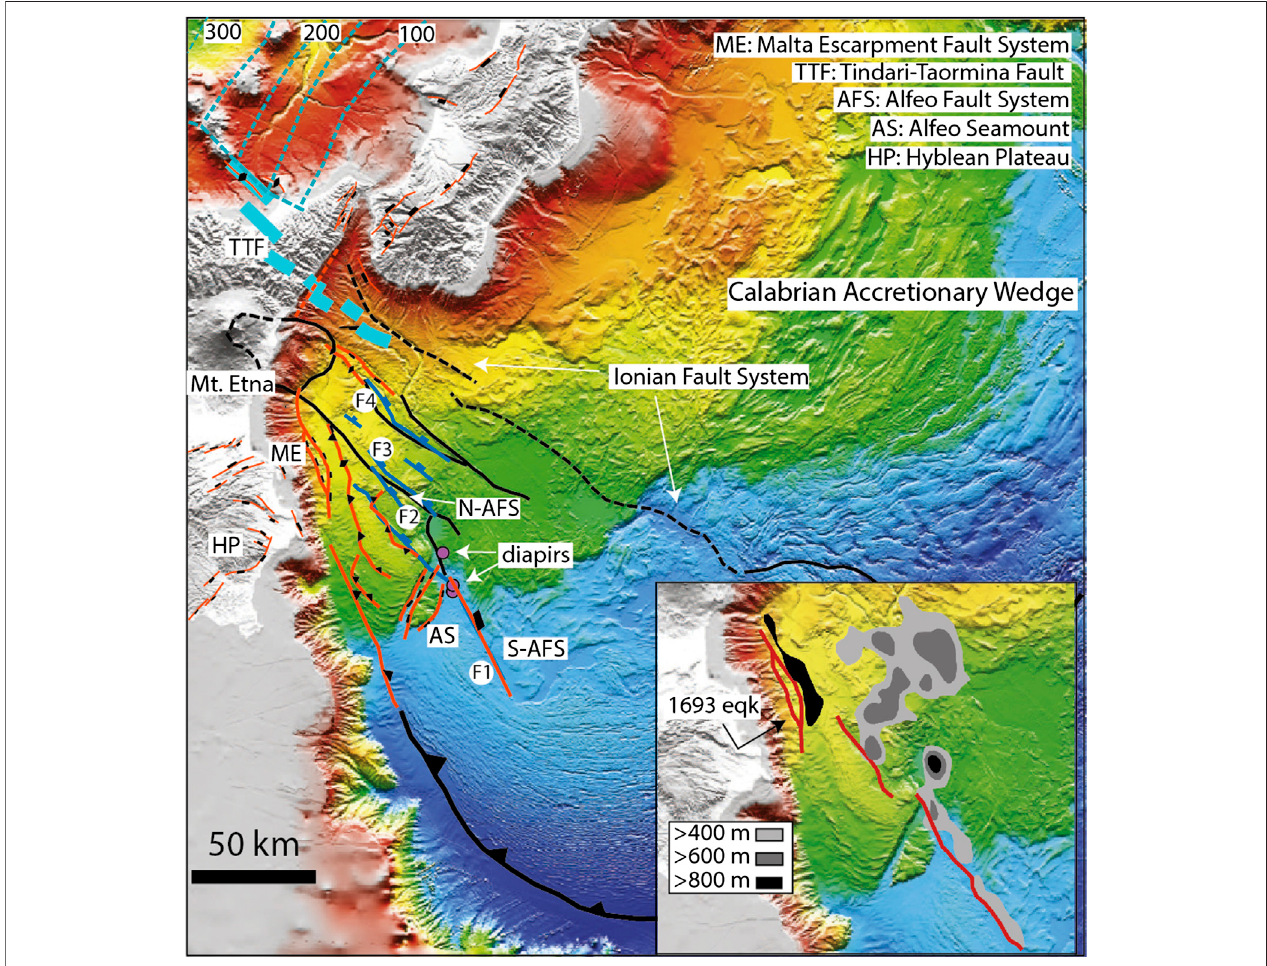
FIGURE 1 | Simpli fi ed tectonic map of the western Ionian region, showing a compilation of the main structural features. Faults are from Argnani, 2014 (in red), and from Gutscher et al., 2017 (in black); the deep faults (F1 to F4) of the AFS are from MTB (dark blue); note that F1 was already known from previous literature and was mapped in Argnani, 2014. Lines with rectangles: extensional faults; lines with triangles: thrusts and reverse faults, lines with diamonds: anticlines. The red dashed line in the Messina Strait represents a fl exure. The North and South branches of the AFS are after Gutscher et al. (2017). The diapirs mapped by MTB are also indicated. Thick,dashedlightbluelinesindicatethetraceoftheTindari-TaorminaFault(afterBarrecaetal.,2019).Thedashedlightbluelinesaredepthcontoursinkmofthetopof thesubducted slabintheTyrrhenian region(fromFrepoliet al.,1996).Thestructures aresuperimposed onthemorpho-bathymetryofGutscheretal.(2017).Themapin the inset shows the thickness of the sedimentary basins along the AFS (from MTB) and the Malta Escarpment (from Argnani and Bonazzi 2005). Basin-bounding faults are in red, and the possible fault responsible for the 1693 earthquake and tsunami is also indicated (after Argnani et al., 2012).